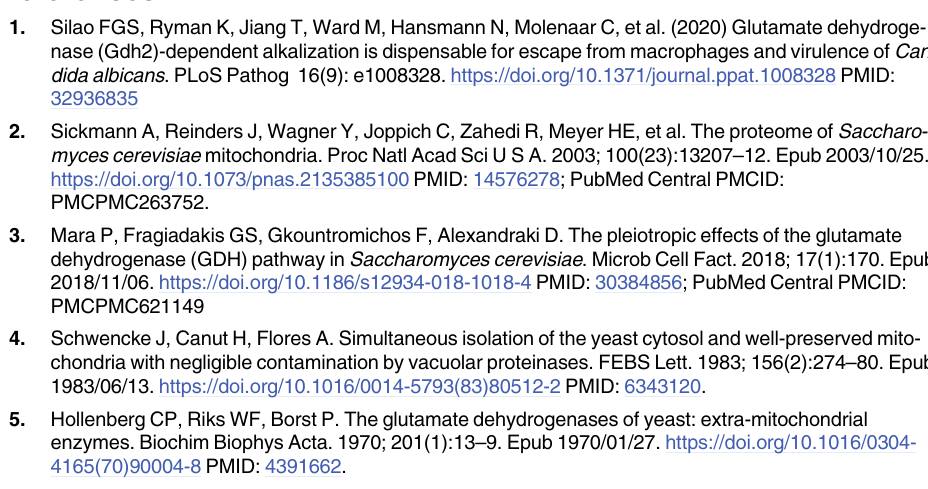
Table); strain CAI4 served as untagged control (middle left panel). CFG273 was transformed with the CRISPR/Cas9 cassette to inactivate GDH2 . Putative gdh2 -/- clones were identified as described and verified by PCR-RD (p13/p6; S2 Table) resulting in strain CFG400. Strains CFG273 ( GDH2/GDH2-GFP ) and CFG400 ( gdh2 / gdh2-GFP ) were grown at a starting OD 600 � 2 in SE medium with 0.2% glucose and 1 mM proline (SED 0.2%+Pro) for 2 h. In contrast to CFG273, strain CFG400 failed to express Gdh2-GFP as assessed by immunoblot (middle right panel) and microscopy (lower panels; Scale bar = 5 μ m), demonstrating the specificity of CRISPR/Cas9. S6 Fig. Gdh2 expression is repressed by glucose. (A) Cells expressing GDH2-GFP (CFG273) were collected from YPD overnight cultures, washed, and then diluted in liquid YNB+CAA with or without the indicated concentrations of glucose or glycerol at OD � 2.0 and then 600 incubated under aeration at 37˚C. Cells were harvested at the indicated time points and then immediately washed with ddH O for microscopic examination of Gdh2-GFP expression. Rep- 2 resentative images of cells from each condition with their relative expression of Gdh2-GFP are shown. Results obtained for the strain CFG219 ( PUT2-GFP ) are shown for comparison. Scale bar = 10 μ m. (B) (Left) Cells collected from no addition (T = 4h) were stained with MitoTracker Deep Red (MTR; 200 nM) and then observed by confocal microscopy (LSM800) using the Air- yscan detector. The Gdh2-GFP and MTR signals are mutually exclusive whereas the Put2-GFP colocalizes with MTR; Scale bar = 2 μ m. (Right) Quantification of mean fluorescence intensity (MFI) from at least 3 biological replicates per condition ( � 150 cells/replicate) are shown. (TIF) S1 Vid. A) Gdh2-GFP (CFG273) is induced upon phagocytosis by RAW264.7 macrophages (Fig 4B). B) Put2-GFP (CFG219) is induced upon phagocytosis by RAW264.7 macrophages (Fig 4B). S2 Vid. A) Gdh2-GFP (CFG273) is induced upon phagocytosis by primary murine BMDM. B) Put2-GFP (CFG219) is induced upon phagocytosis by primary murine